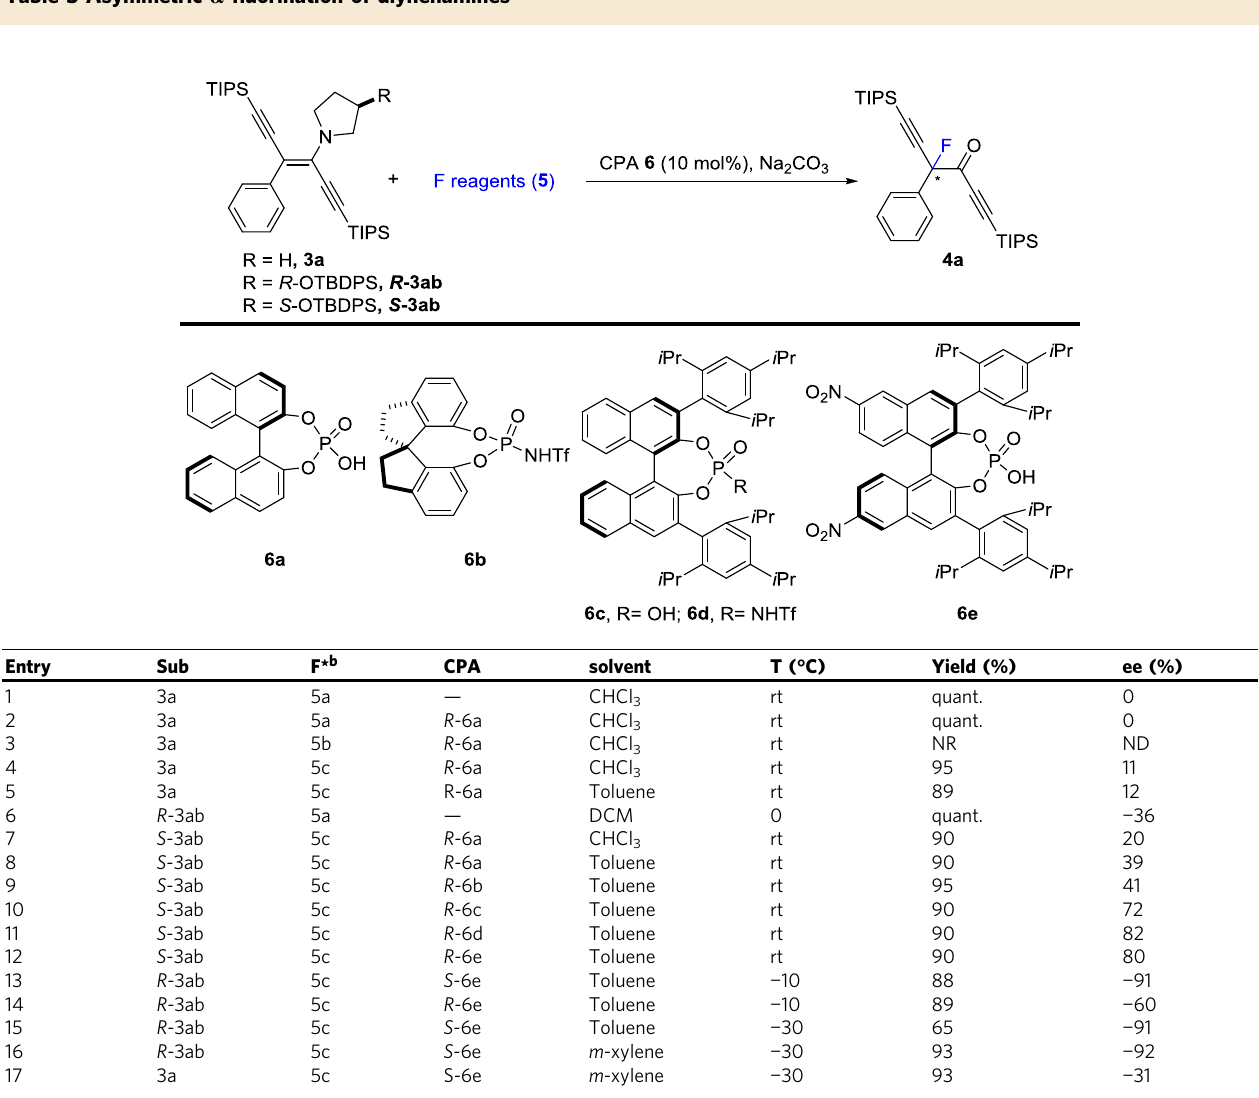
Table 3 Asymmetric α - fl uorination of diynenamines